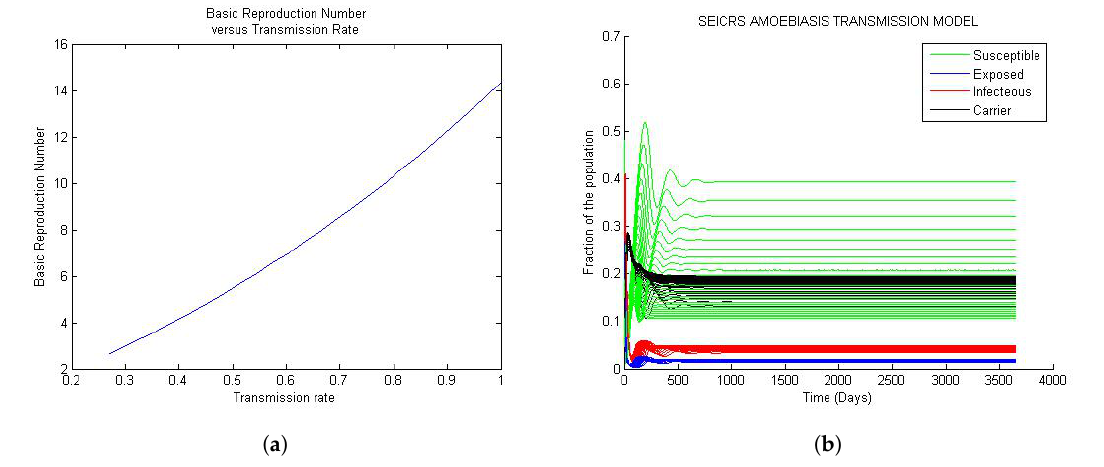
Figure 3. General trend of the model when R 0 is greater than one: ( a ) Curve of the R 0 versus β ; ( b ) 25 solution curves of the model.